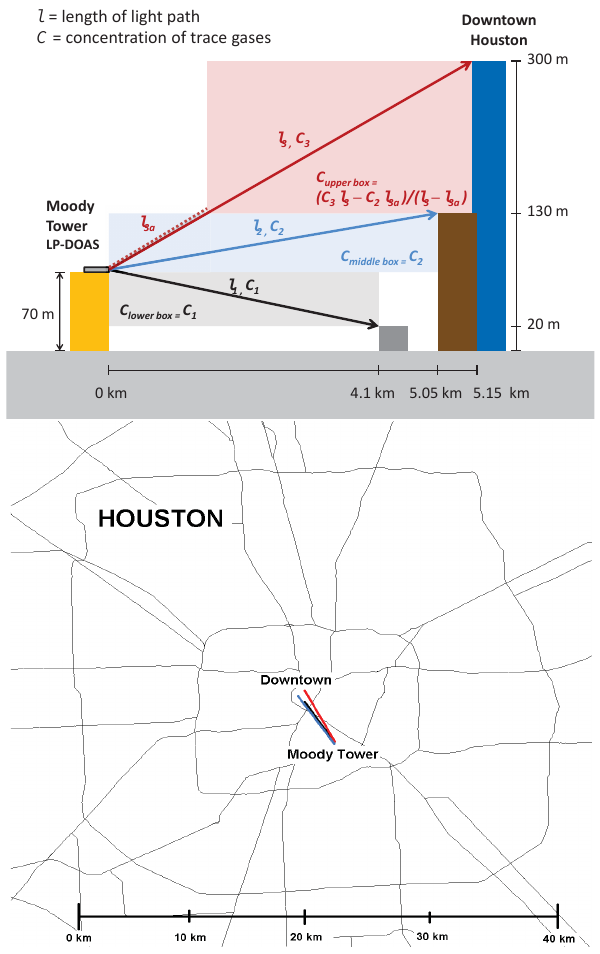
Fig. 2. Light path arrangement of the LP-DOAS systems during TRAMP 2006.